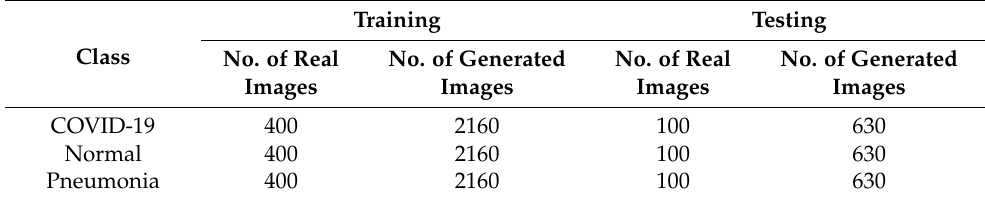
Figure 12. The number of real images and generated images in the training and testing process. Table 5. The number of images for the training and testing process for each class.